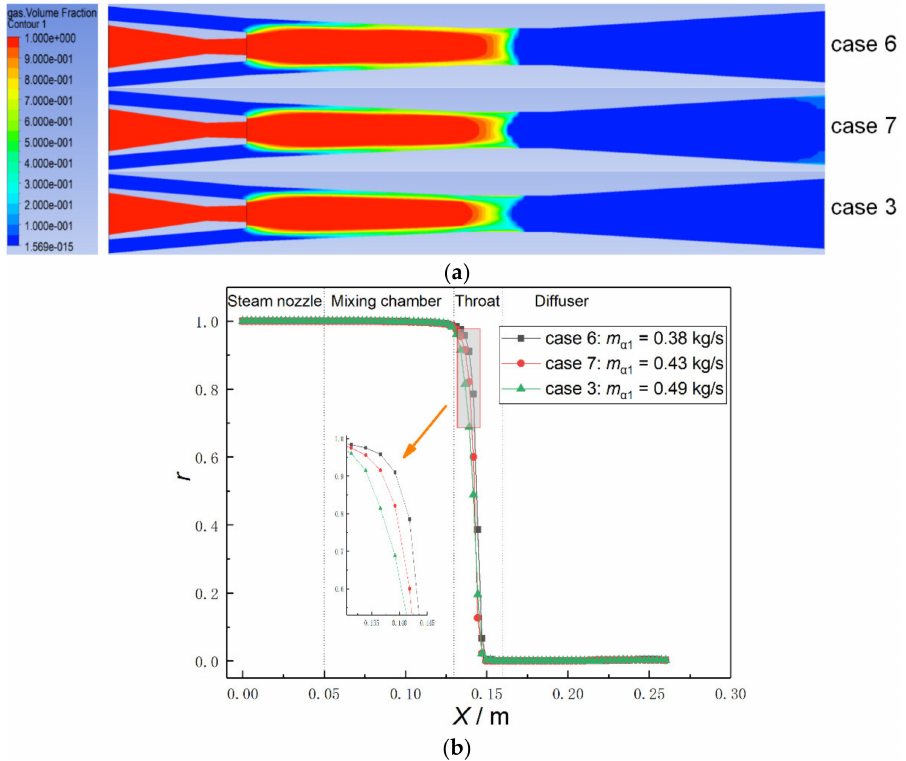
Figure 10. Effect of water inlet mass flow rate m α 1 on steam volume fraction. ( a ) Contours of steam volume fractions at different water inlet mass flow rates; ( b ) Axial profiles of steam volume fractions at different water inlet mass flow